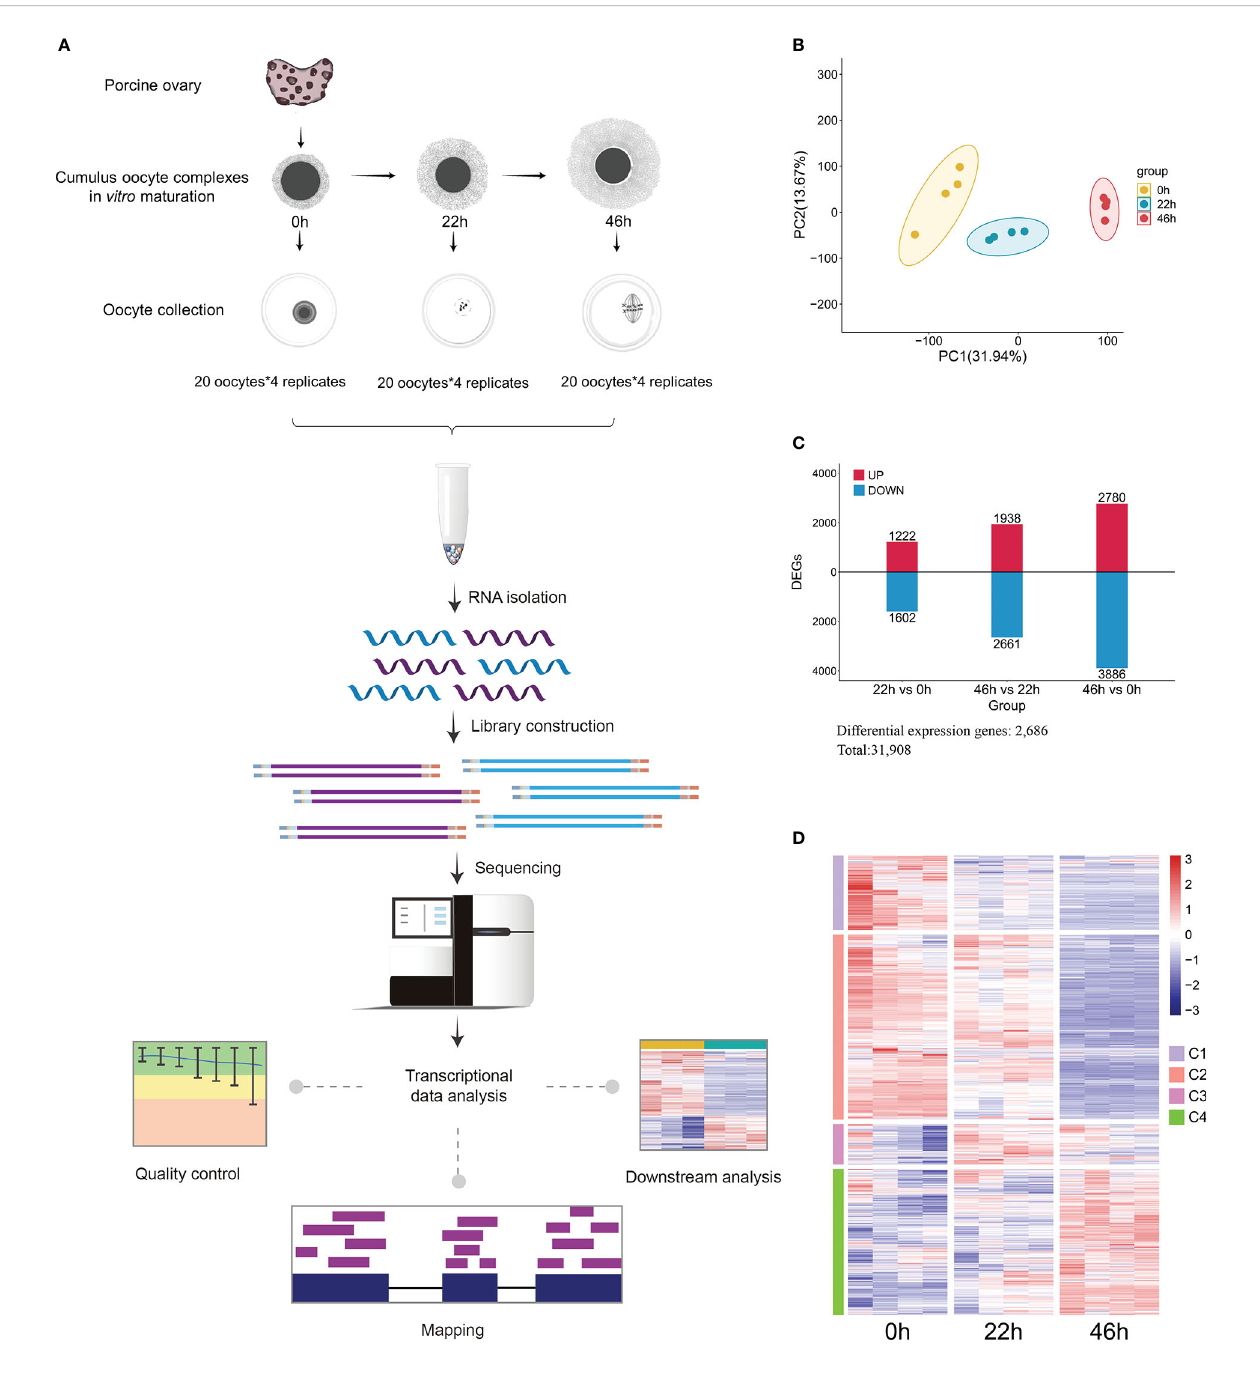
FIGURE 2 Transcriptomic pro fi ling of porcine oocyte maturation. (A) Schematic overview of the work fl ow for transcriptome pro fi ling in oocytes. (B) PCA plot for transcriptomic datasets separating 0h, 22h, and 46h oocyte samples. (C) Bar chart showing the up-regulated and down-regulated DEGs. (D) Heat map of hierarchical clustering of 2,686 differentially expressed genes from porcine oocytes cultured in vitro at key time